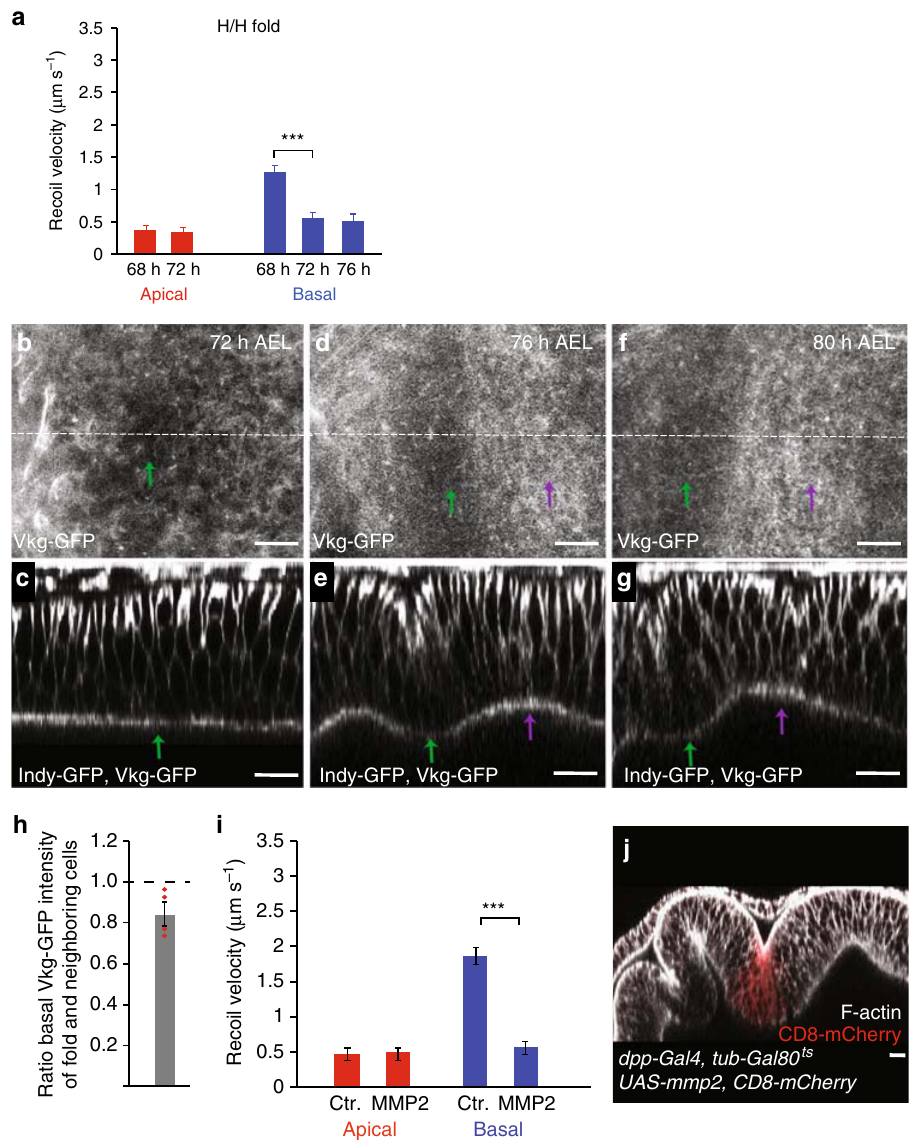
Fig. 5 Local reduction of ECM and basal tension in H/H fold. a Average recoil velocity of the two vertices at the end of an ablated cell edge in the H/H pre- fold region within 0.25 s after ablation for wing imaginal discs of the indicated times AEL. Recoil velocities are shown for ablations of apical and basal cell edges, as indicated. Mean and s.e.m. are shown ( n = 15 cuts) (*** p < 0.001, Student ’ s t -test). b – g Basal ( b , d , f ) and cross-sectional ( c , e , g ) views of wing imaginal discs at the indicated stages expressing Vkg-GFP and Indy-GFP are shown. Green and magenta arrows point to the H/H and H/P fold, respectively. Scale bars are 10 μ m. h Ratio of basal Vkg-GFP pixel intensity for H/H fold cells and neighboring cells of 72 h AEL wing imaginal discs are shown. Mean and s.e.m. are shown ( n = 4 wing imaginal discs). i Average recoil velocity of the two vertices at the end of an ablated cell edge of control cells and cells expressing MMP2 within 0.25 s after ablation. Recoil velocities are shown for ablations of apical and basal cell edges, as indicated. Mean and s.e.m. are shown ( n = 15 cuts) (*** p < 0.001, Student ’ s t -test). j Cross-sectional view of a wing imaginal disc expressing MMP2 in a stripe of cells under control of dpp-Gal4 labeled by expression of CD8-mCherry (red). F-actin staining is shown in gray. Larvae were incubated for 24 h at 29 °C before dissection to induce MMP2 expression. Scale bar is 10 μ A simpli fi ed picture resulting from our mechanical analysis stabilization via binding to integrins, reducing the active ten- of how basal tension reduction can induce fold formation is as sion it can generate with myosin molecular motors. Alter- follows (Fig. 8). Higher basal tension in the cells outside the natively, the ECM and cortical actomyosin network, linked fold compared to cells inside the fold stretches the basal surface together via integrins and other molecules, can be seen as a areas of fold cells. Consequently, fold cells widen basally and single composite material under tension 34 . Elastic straining of reduce cell height to maintain cell volume. The new force the ECM, e.g. during tissue growth, could give rise to a passive balance state is characterized by apical indentation and wedge- mechanical tension within the ECM. As the ECM is depleted, shaped, shortened cells. How is ECM depletion linked to a the composite material is reorganized and passive ECM stress decrease in basal cell edge and surface tension? In one scenario, due to ECM straining could be lost, also contributing to the following ECM depletion, the actomyosin network lacks overall decrease in basal tension in the fold.